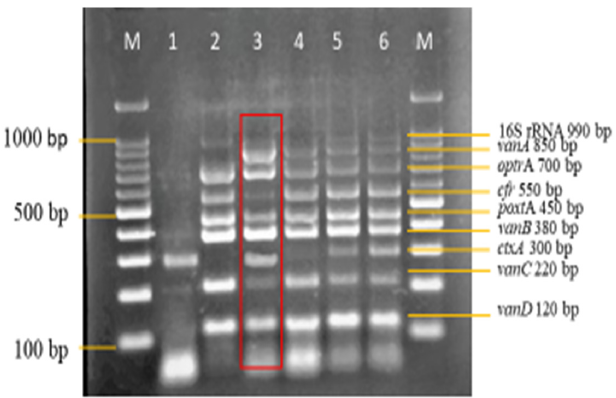
Figure 5. Taq DNA polymerase concentration optimization in the multiplex PCR. A concentration of 0.75 units on lane 3 from a range of concentrations (0.5–1.50 units) was selected as the optimum concentration. Lane M: DNA ladder 100 bp plus. Lane 1: Negative control with ctxA (Internal control). Lane 2: 0.50 Units. Lane 3: 0.75 Units. Lane 4: 1.00 Units. Lane 5: 1.25 Units. Lane 6: 1.50 Units.